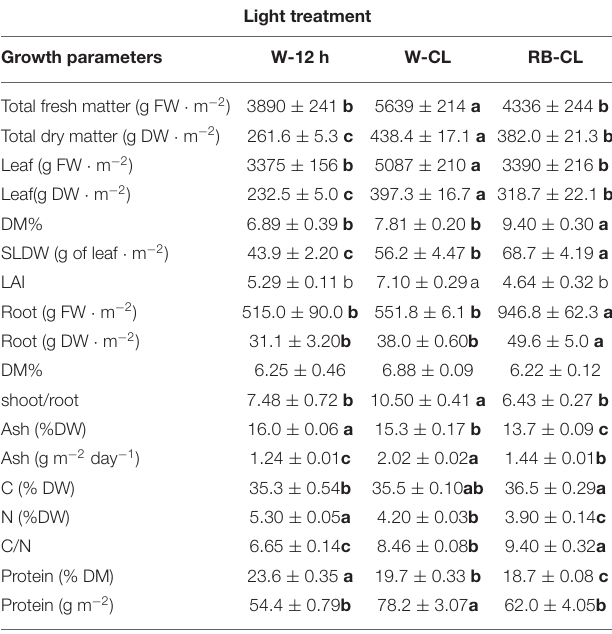
TABLE 3 | Non-structural carbohydrate (NSC, mg · 100g FW − 1 ) content in the roots of Eruca vesicaria (L.) Cav. grown under three different light treatment